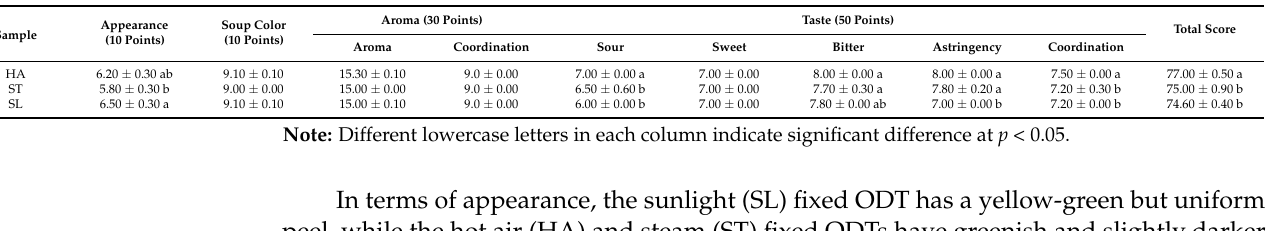
Table 1. Sensory evaluation of ODT samples with different fixing